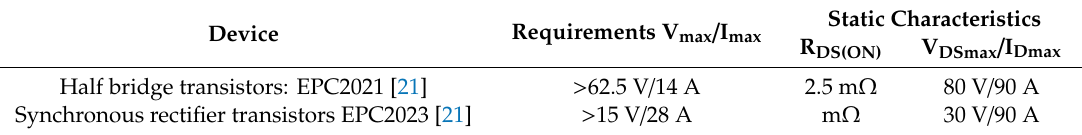
Table 2. Requirements and characteristics of the selected transistors.